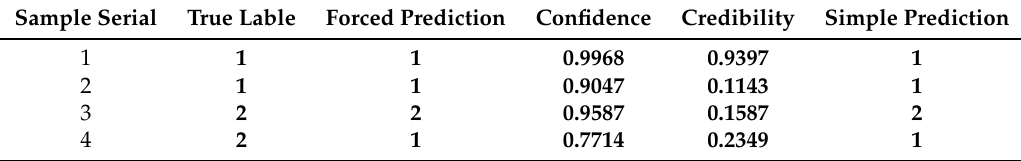
Table 3. Typical individual prediction with CP-1NN (conformal prediction based on 1NN).